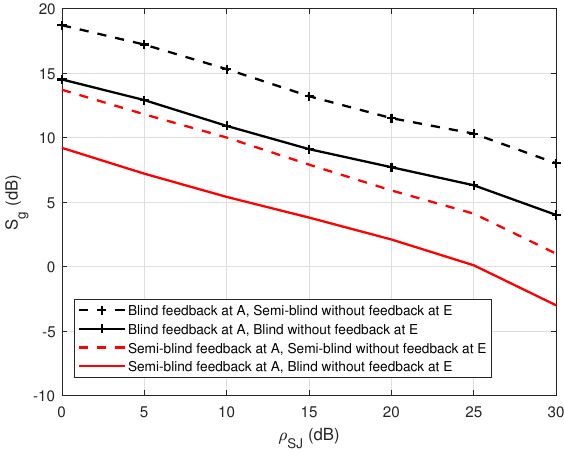
Figure 22. S g versus ρ SJ in case of an active